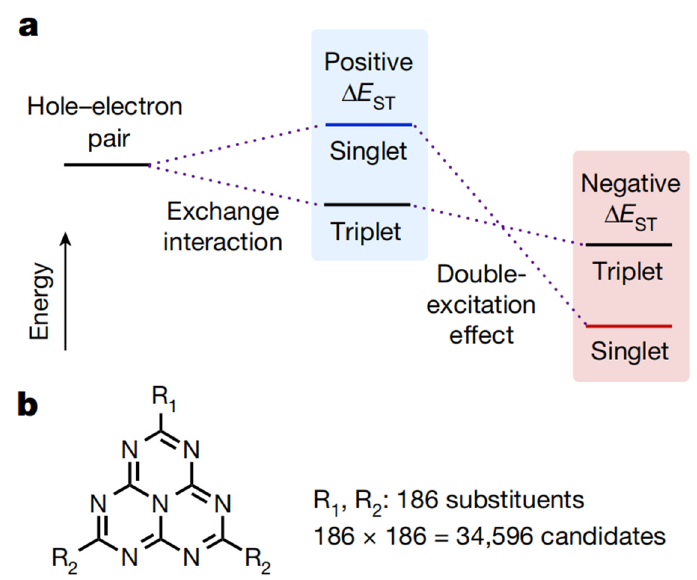
Figure 13. ( a ) Schematic diagram of singlet and triplet excited states split in energy by the exchange interaction (middle) and then inverted by including the double-excitation effect (right); ( b ) molecular structures of the heptazine analogues examined in the computational screening. Reproduced with permission from Naoya Aizawa et al., “Delayed fluorescence from inverted singlet and triplet excited states”; published by Springer Nature , 2022 [82].